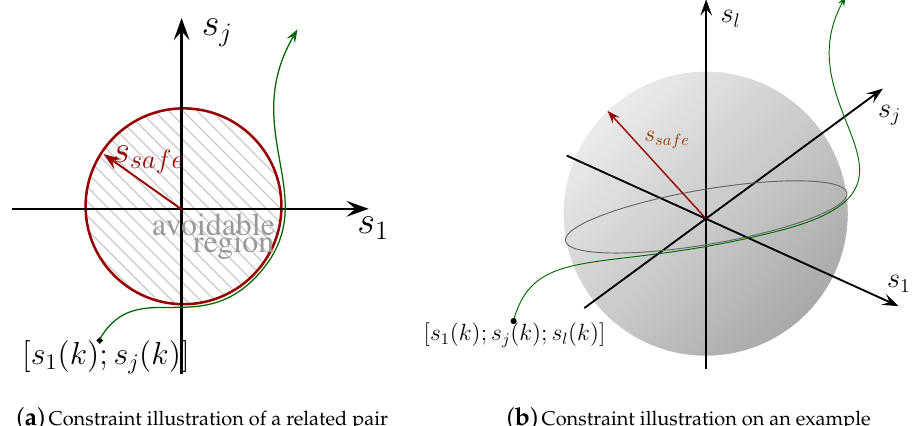
Figure 1. Geometrical illustration of the quadratic